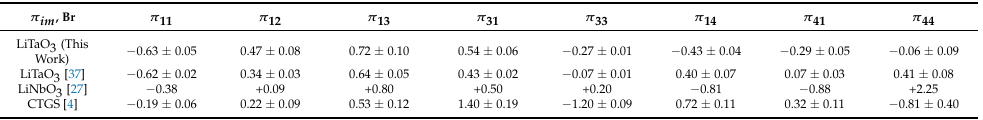
Table 4. All independent piezo-optic coefficients π im of LiTaO 3 , LiNbO 3 and CTGS crystals ( λ = 632.8 nm, T = 20 ◦